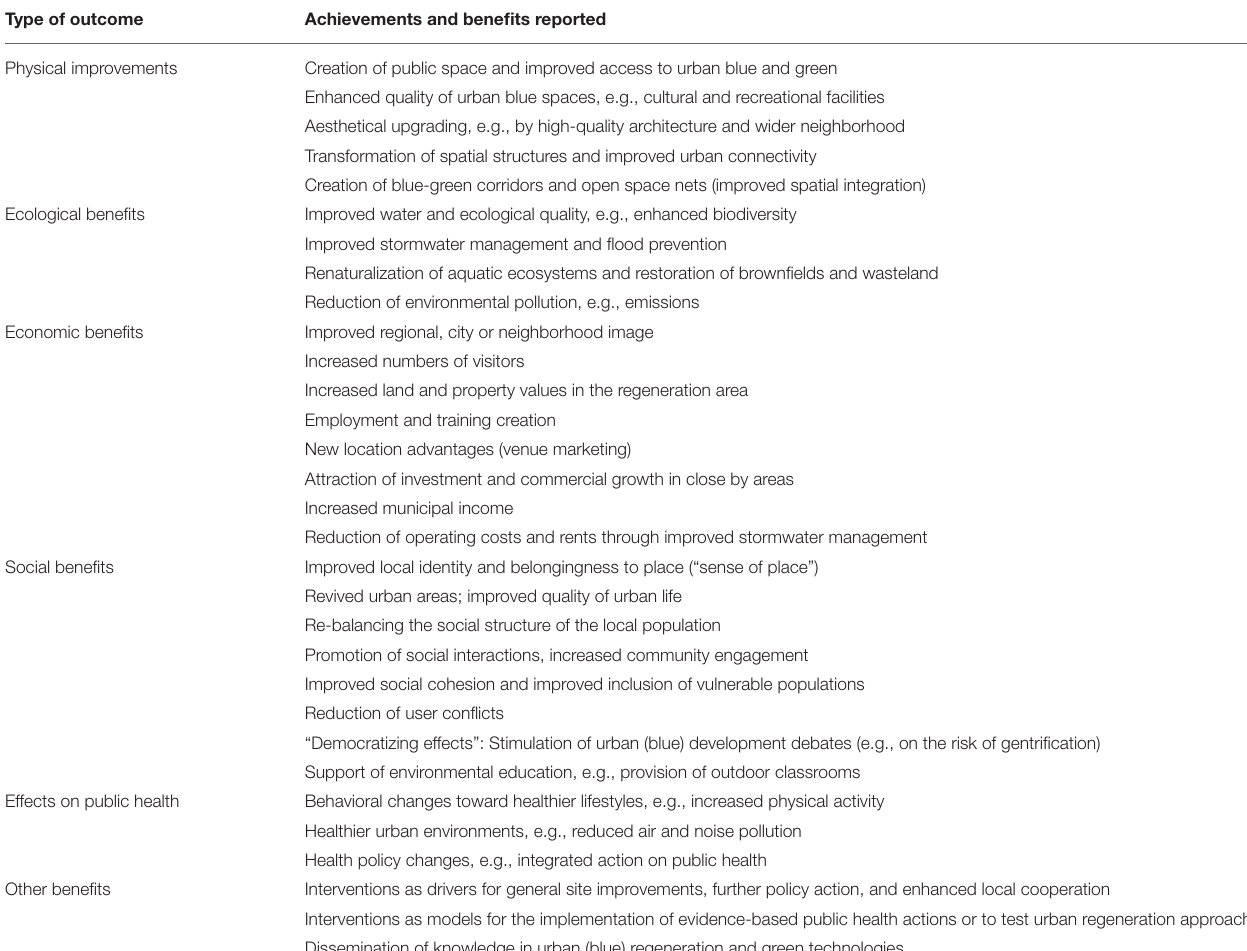
TABLE 5 | Achievements and benefits in the projects